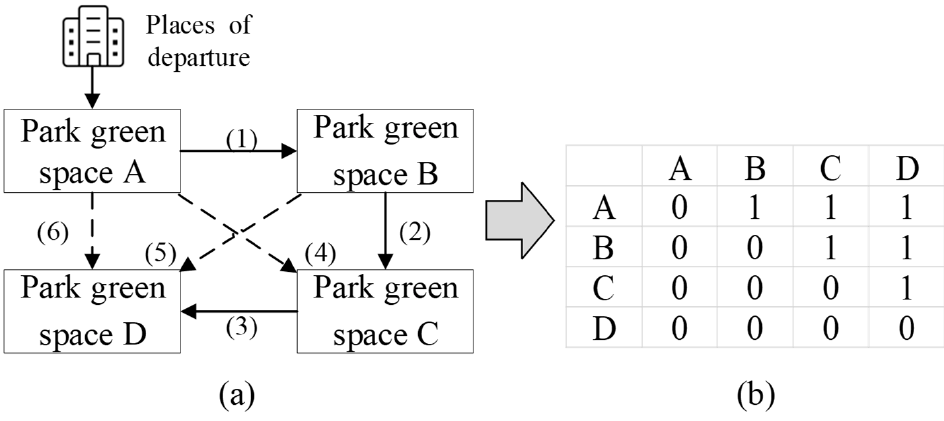
Figure 2. The relationship between the green spaces and their nodes: ( a ) the network diagram; and ( b ) the network matrix. ( b ) the network